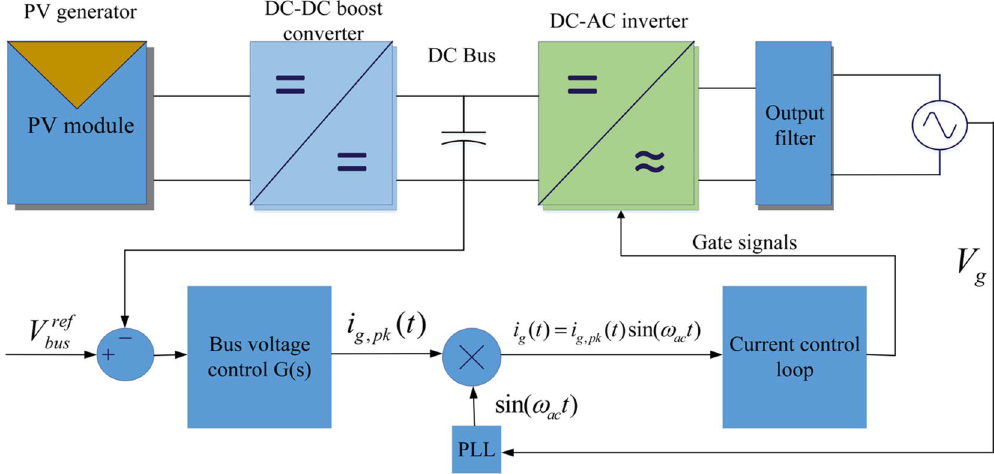
Figure 1. A single phase PV/BES grid-connected system with a common DC-Bus control